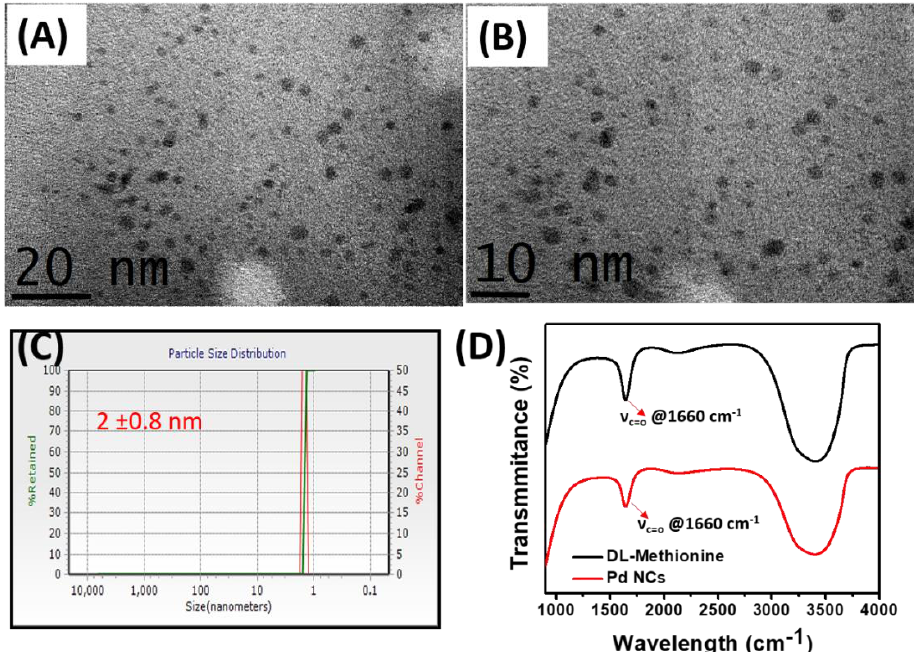
Figure 1. Characterization of Pd NCs. ( A , B ) represents the high resolution transmission electron microscopy (HR-TEM) images of Pd NCs. ( C ) Dynamic light scattering (DLS) size distribution of Pd NCs. ( D ) FT-IR spectra of Pd NCs and DL-Methionine.